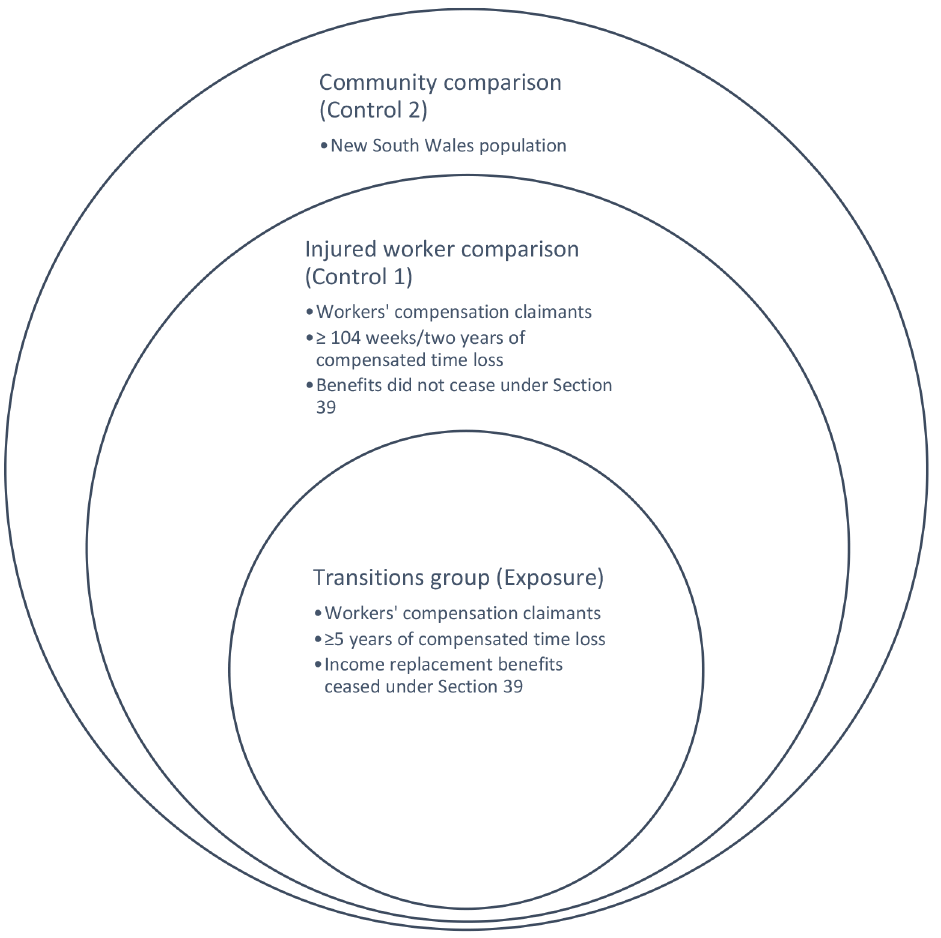
Figure 1: Schematic representation of Exposure and Comparison groups; each (mutually exclusive) nested group reflects its position of a subset of the larger group, from the New South Wales population to injured workers with a long-duration income-replacement claim ( ≥ 104 weeks/two years), to injured workers with a long-duration income-replacement claim ( ≥ 260/five years) that ceased under Section 39